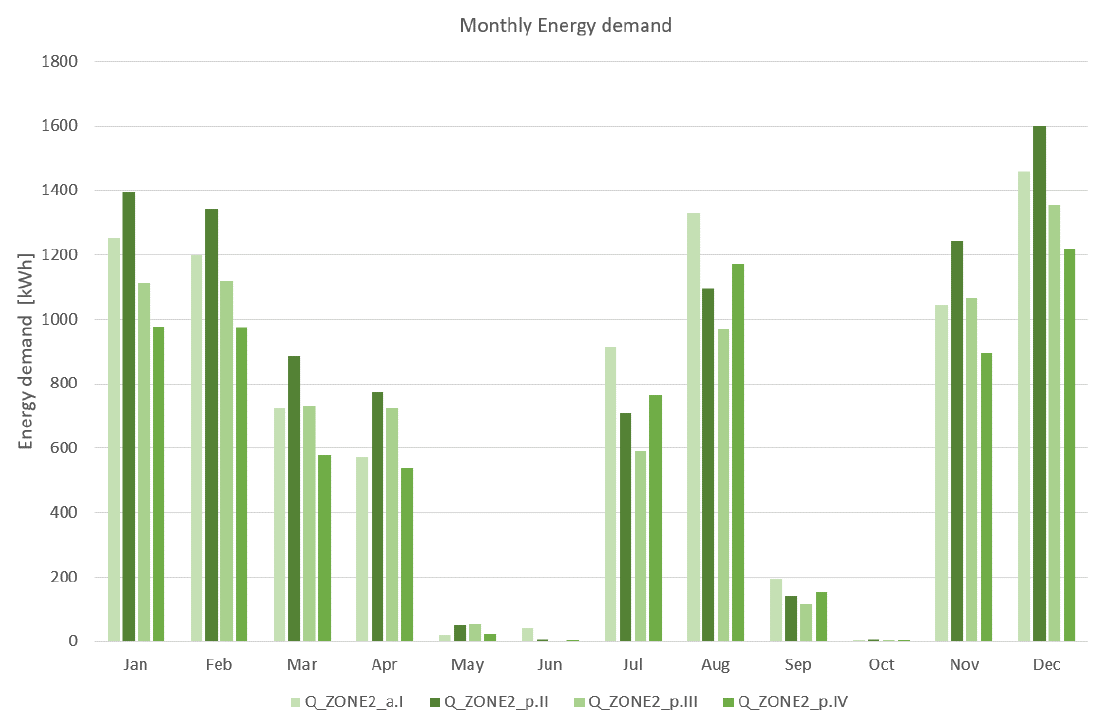
Figure 8. Monthly energy demand: comparison between thermal performance in current and optimized configurations for a typical inner floor with high transparent percentage (floor 2).